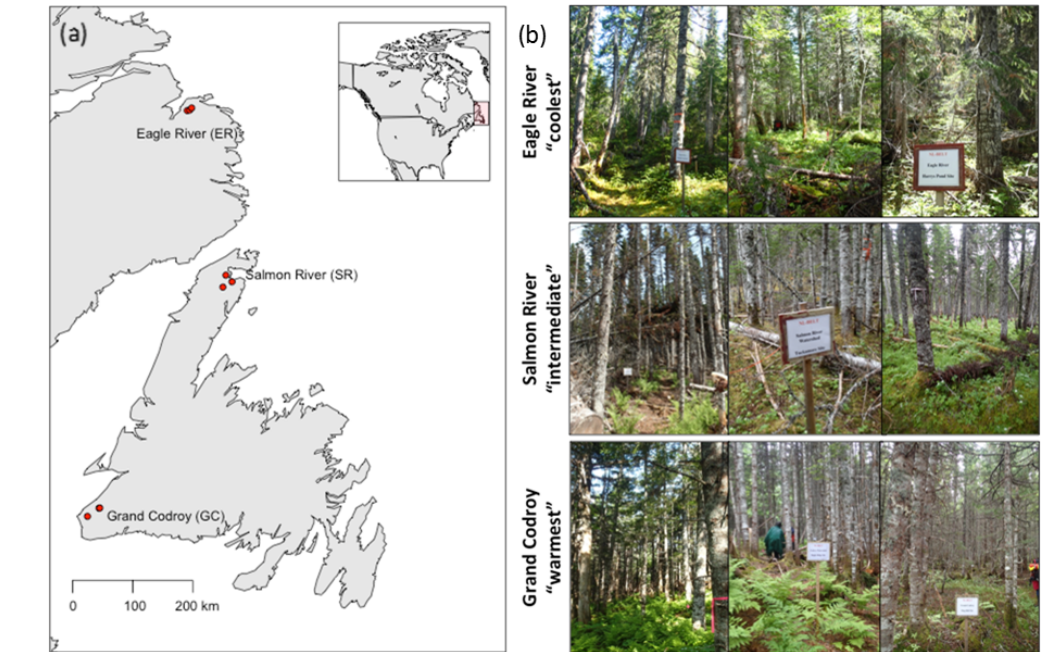
Figure 1. (a) Map and (b) pictures of the three forests in each region along the Newfoundland and Labrador Boreal Ecosystem Latitude Transect (NL-BELT) in Canada. Table 1. Characteristics of the nine forests in the three study regions along the Newfoundland and Labrador Boreal Ecosystem Latitude Transect (NL-BELT) in Canada. Region Coolest Intermediate Warmest Forest ID Muddy Sheppard’s Harry’s Hare Bay Maple